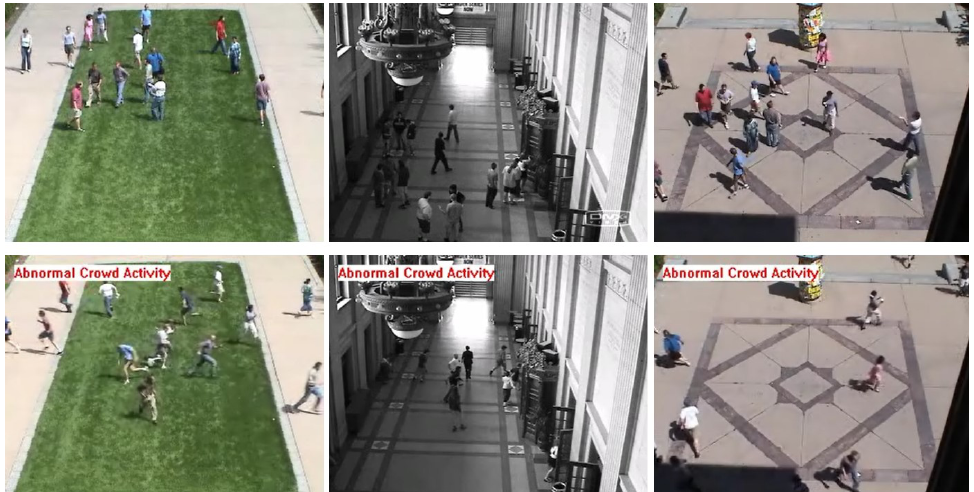
Figure 5. Examples of frames from the UMN dataset are presented. Normal frames are shown in the first row, and abnormal frames are in the second row.